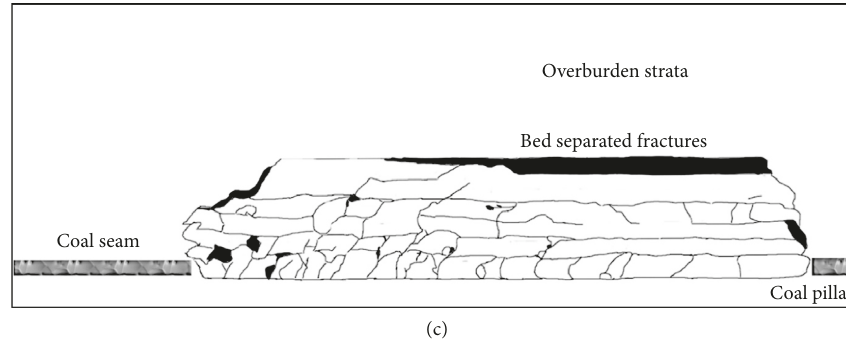
Figure 2: Fracture network diagrams (mining face 5-3). Mining length: (a)850mm; (b)1200 mm;